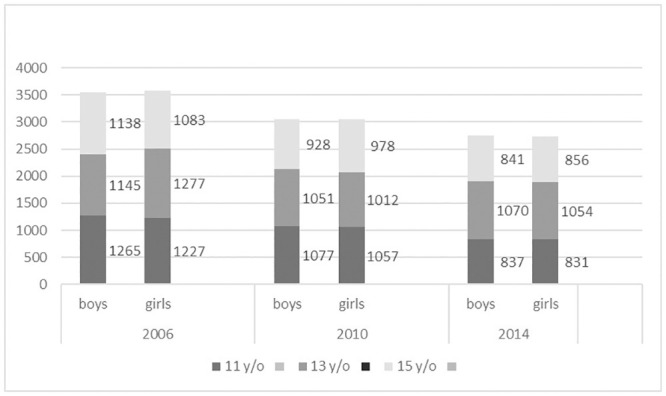
Population according to age, sex and year of study.